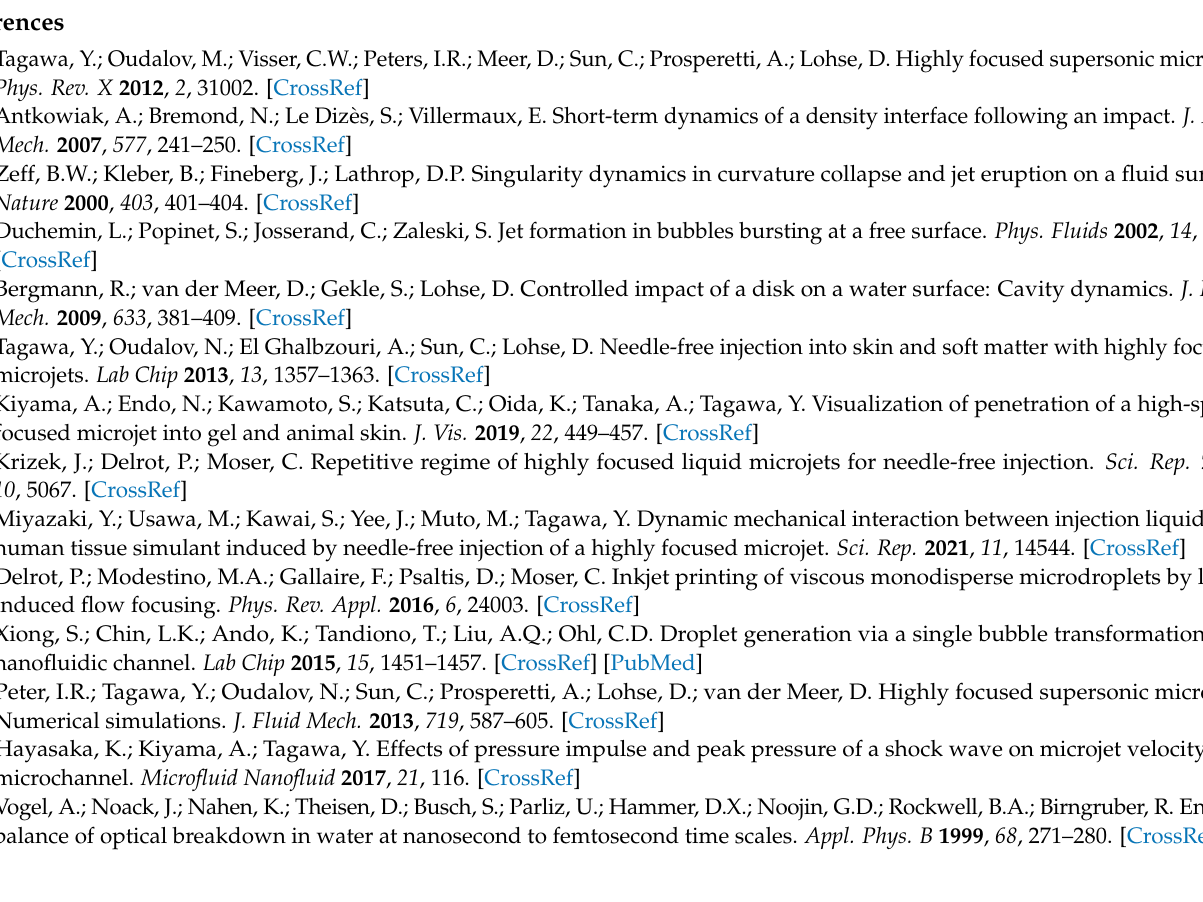
Figure A2. Result of the grid independence study using 𝜌 -THINC-MUSCL3 on w/o-meniscus setting.